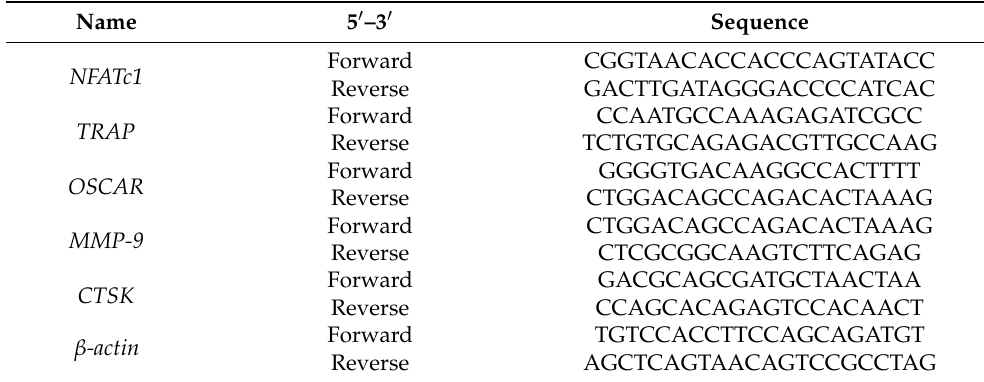
Table 1. Primer sequences for quantitative Real-time Polymerase Chain Reaction